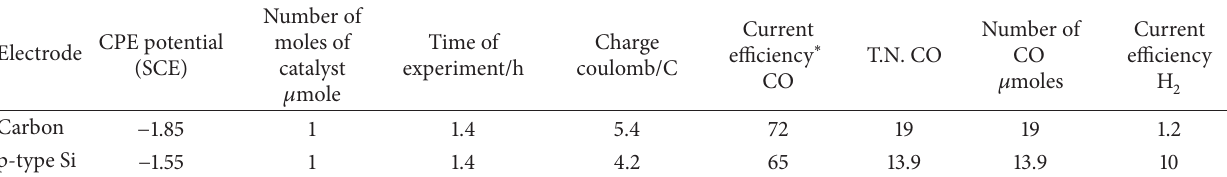
Table 1: Current efficiencies and turnover numbers of electrocatalytic reduction of CO 2 catalyzed by Co(TPP)Cl at both carbon and p-type Si electrodes. T.N. = moles of product/moles of catalyst.